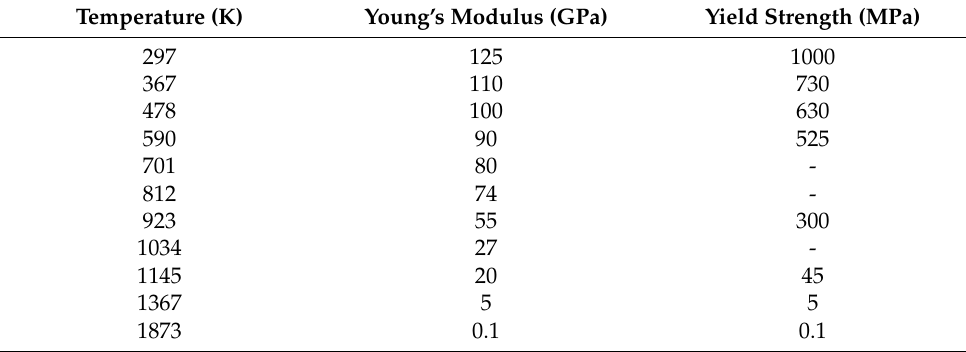
Table 1. Young’s modulus and yield strength of Ti-64 alloy.